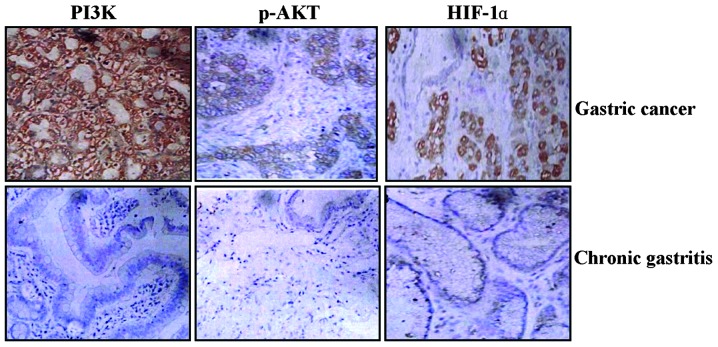
Expression of PI3K, p-AKT and HIF-1α in GC tissues (magnification, ×200). The positive expression of PI3K, p-AKT and HIF-1α was predominantly localized in the cytoplasm of GC tissue cells but was rarely identified in chronic gastritis, and their expression intensities were significantly increased in GC tissue compared with chronic gastritis tissue. PI3K, phosphatidylinositol-3-kinase; p-AKT, phosphorylated-Akt; HIF-1α, hypoxia-inducible factor-1α; GC, gastric cancer.